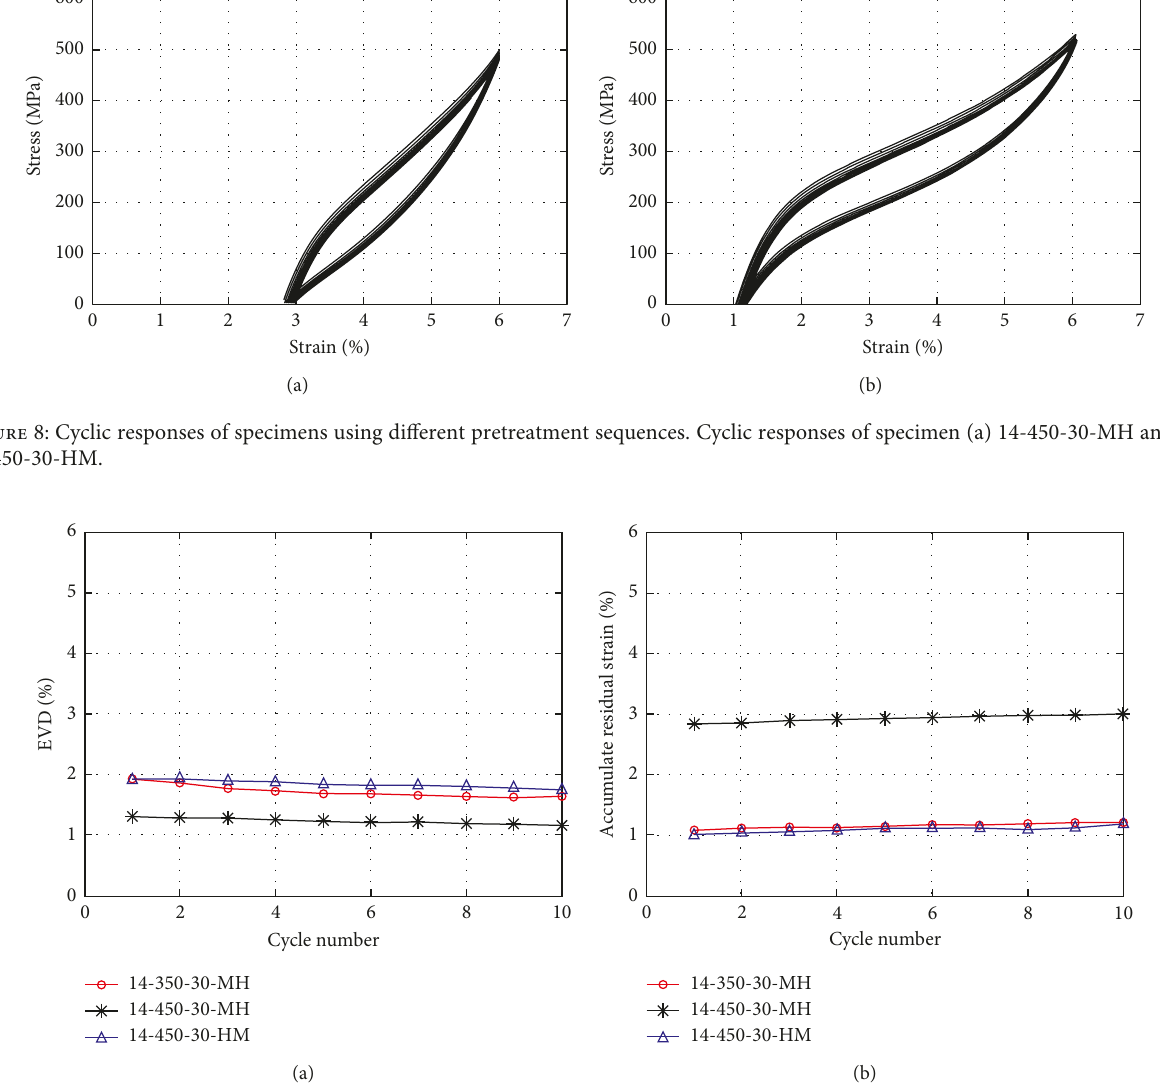
Figure 9: Effect of heat and machining sequence on the mechanical properties. Comparison on (a) EVD and (b) accumulated residual